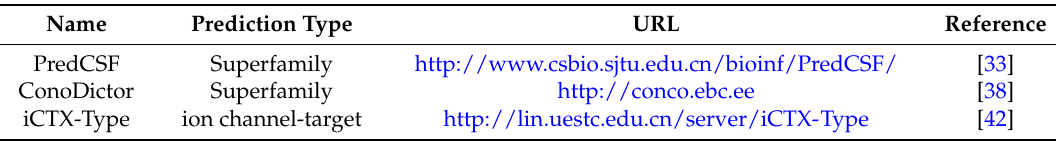
Table 3. A list of the published prediction tools for conotoxin